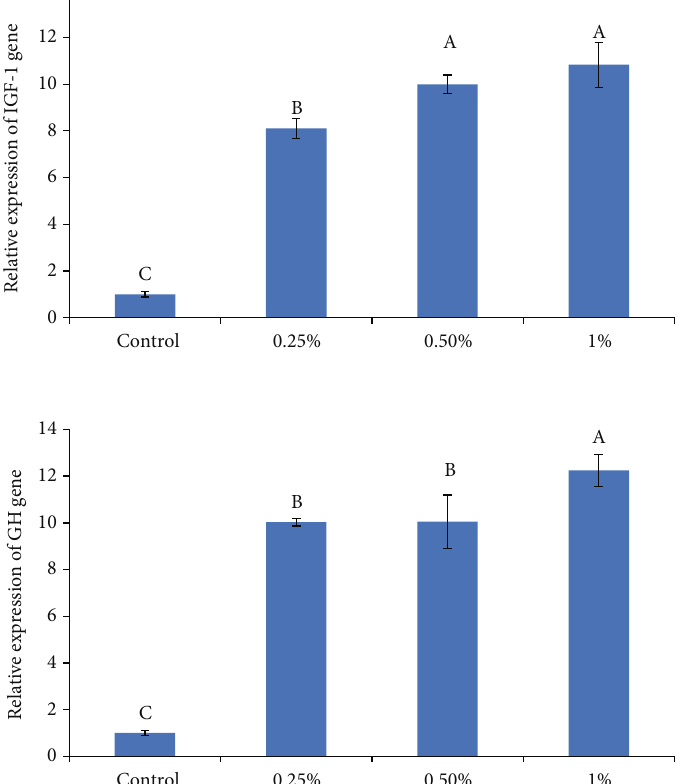
Figure 3: The e ff ects of di ff erent levels of U. intestinalis on GH in brain and IGF-1 in liver of zebra fi sh ( n = 9 ). Values are presented as the mean ± S : D . The bars assigned with di ff erent letter denote signi fi cant di ff erence between treatments ( P < 0 : 05